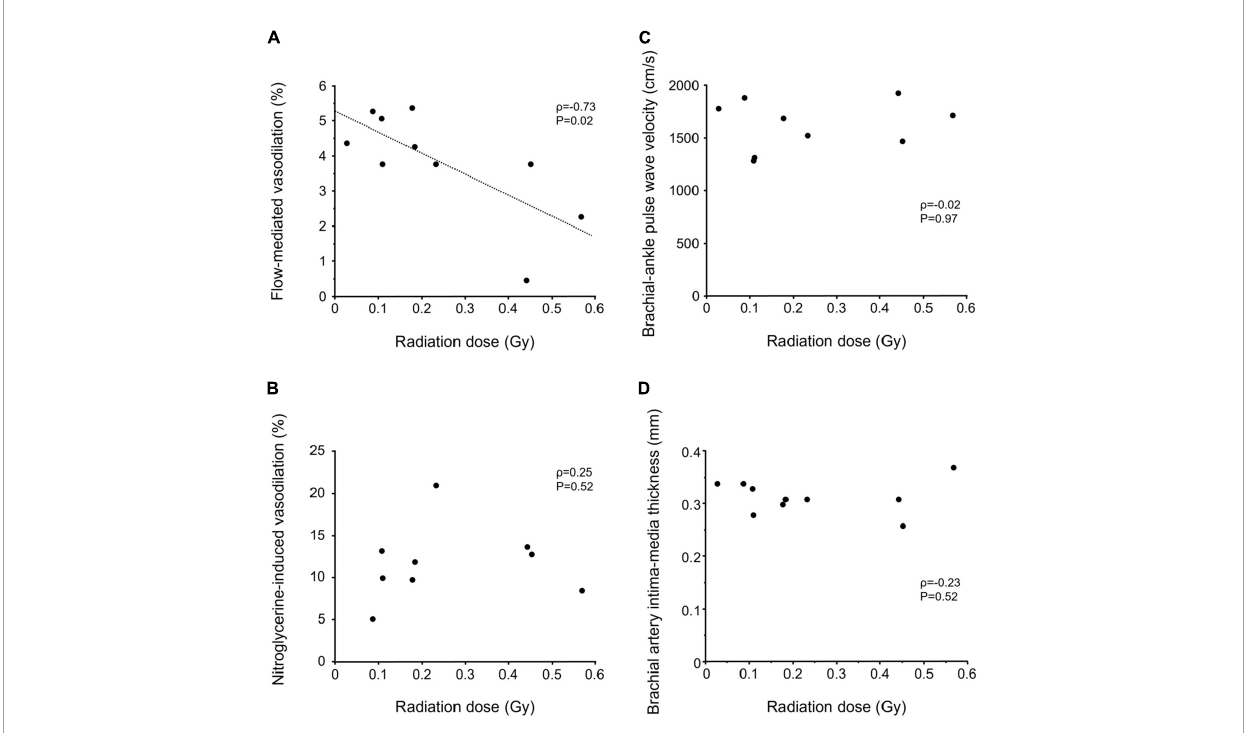
FIGURE2 Scatter plots show relationships of radiation dose with flow-mediated vasodilation (A) , nitroglycerine-induced vasodilation (B) , brachial-ankle pulse wave velocity (C) , and brachial artery intima-media thickness (D) in atomic bomb